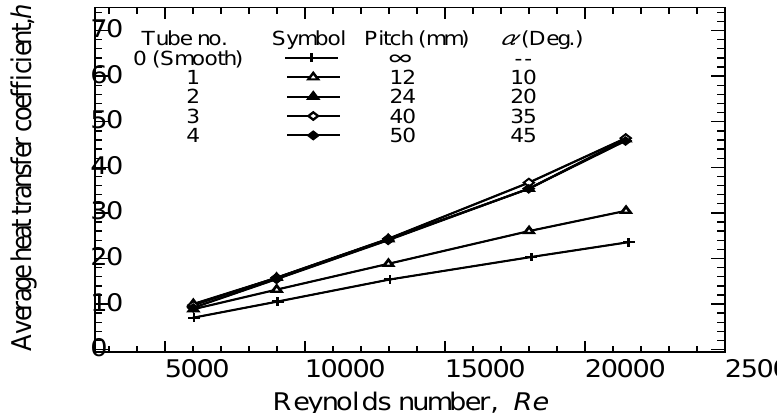
Figure 6: Variation of average heat transfer coefficients against Reynolds number for smooth tube and wire-coil inserted